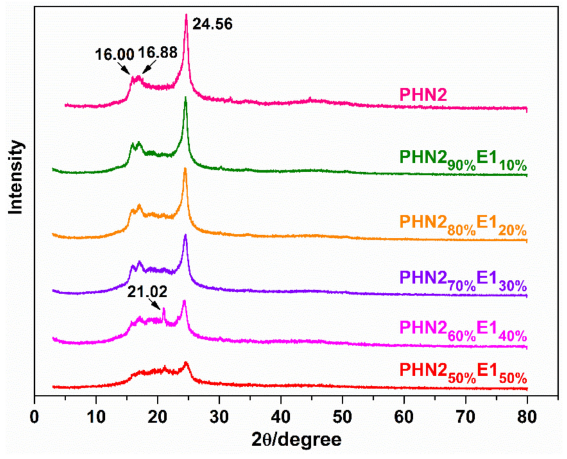
Figure 8. Powder WXRD profiles for PHN2 1 − x E1 x . Table 3. Powder X-ray di ff raction data for PHN2, PHN2 1 − x E1 x , and PHN2 1 − x E2 x